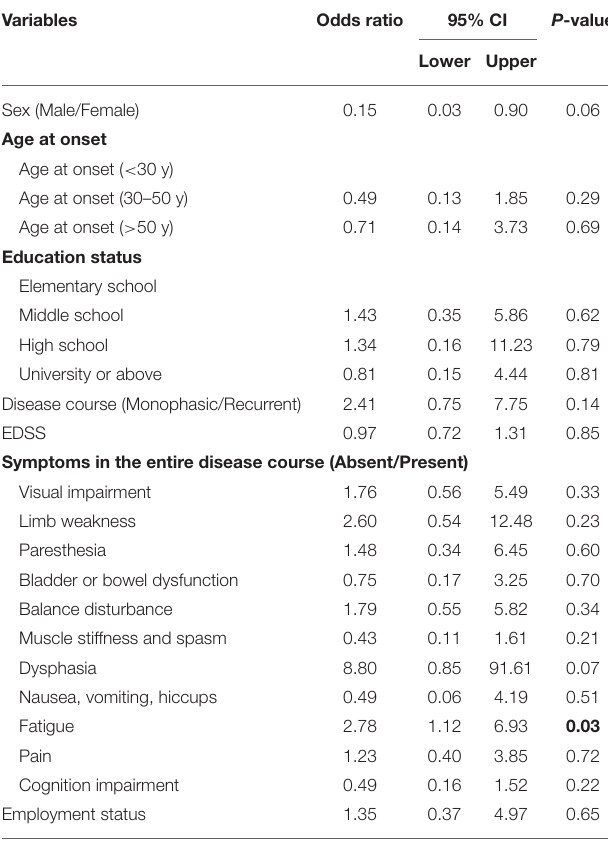
TABLE 4 | Binary logistic regression analysis of factors associated with receiving attack-prevent treatment (No vs. Yes) in